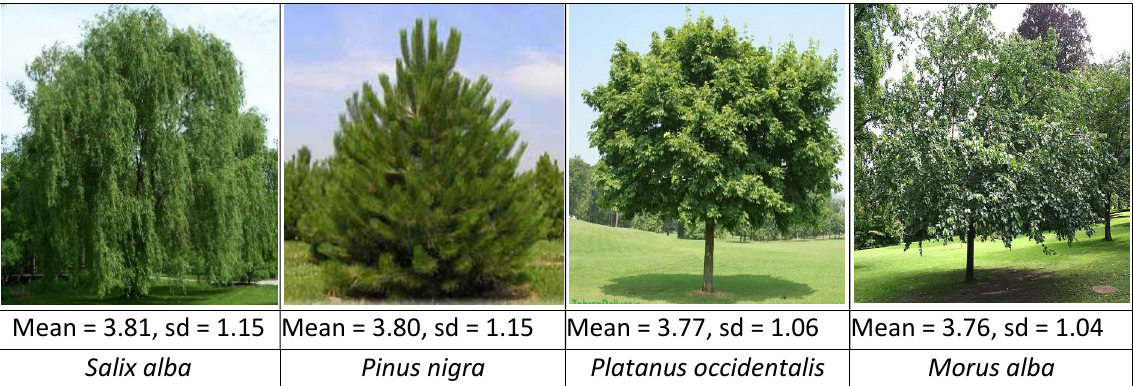
Figure 3b: Public Perceptions for Trees in Urban Parks in Tabriz